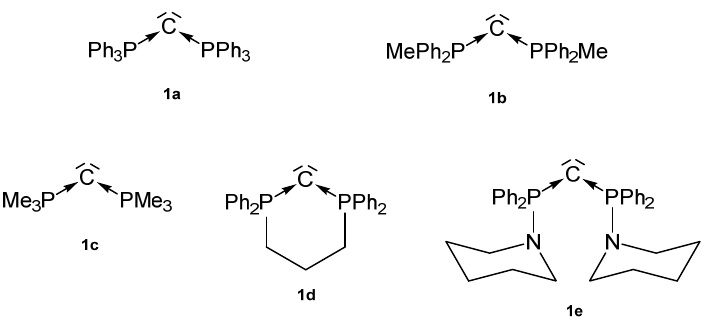
Figure 3. Symmetric carbones 1a – 1e as ligands for transition metal complexes.